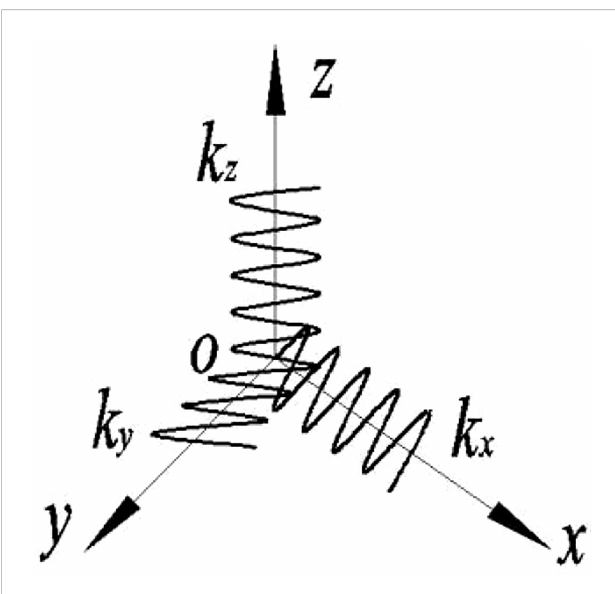
FIGURE 4 Simpli fi ed spring model of a fl exible